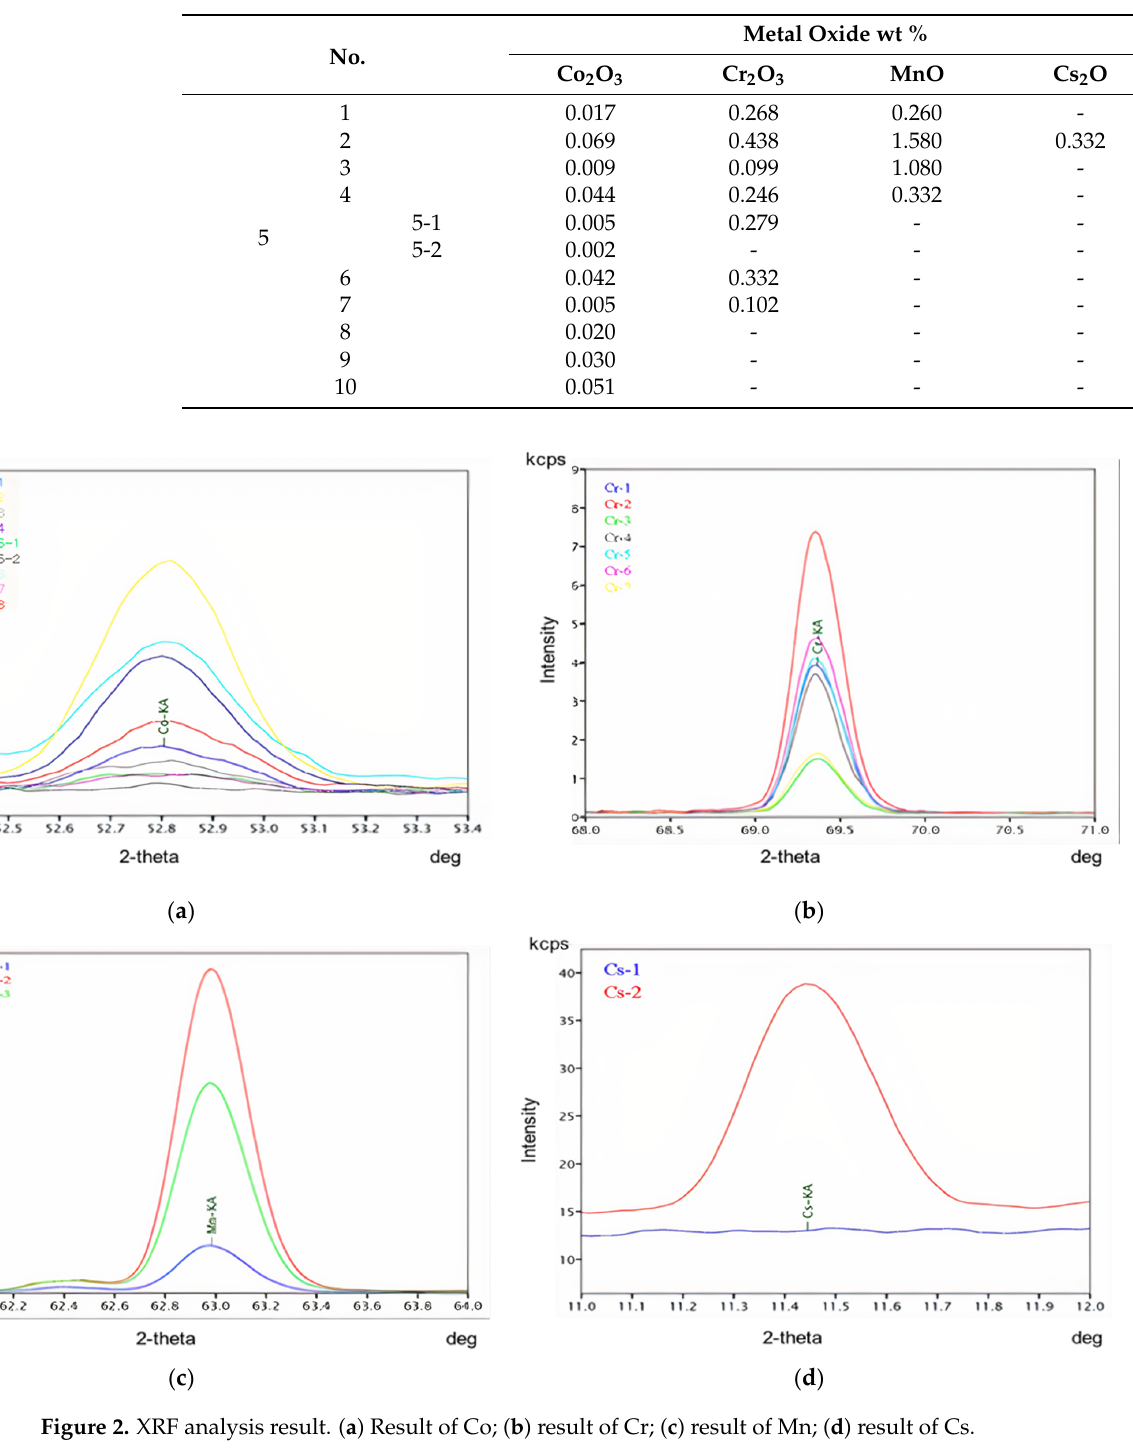
Table 4. XRF analysis results of weight percent of metal oxide.